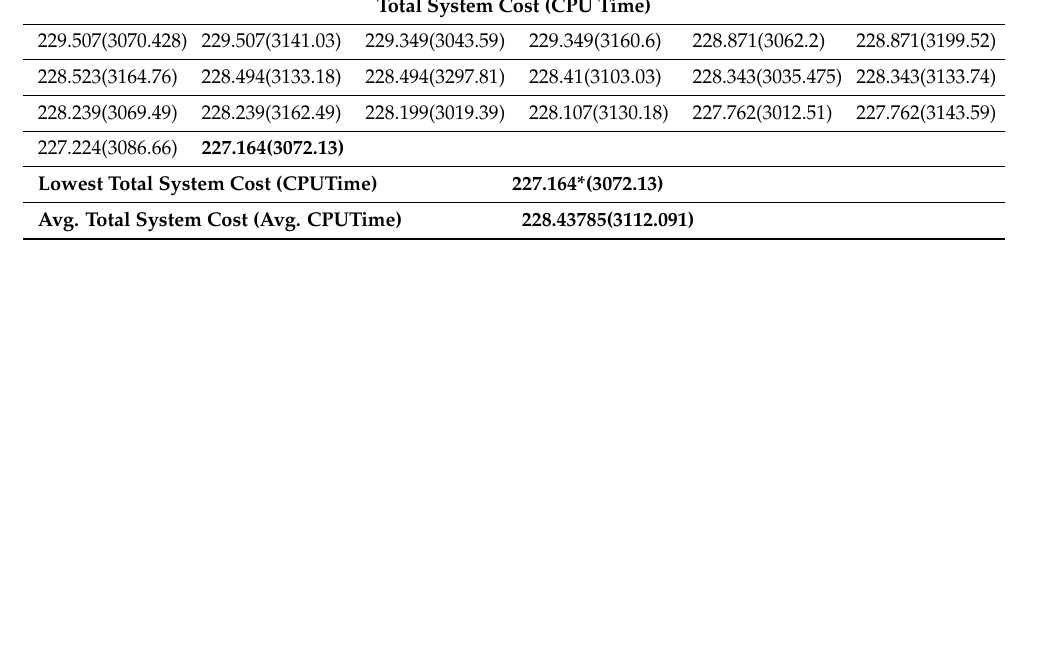
Table 35. The total system costs of 20 simulation runs obtained by ENUM–MGA for the n -stage mixed